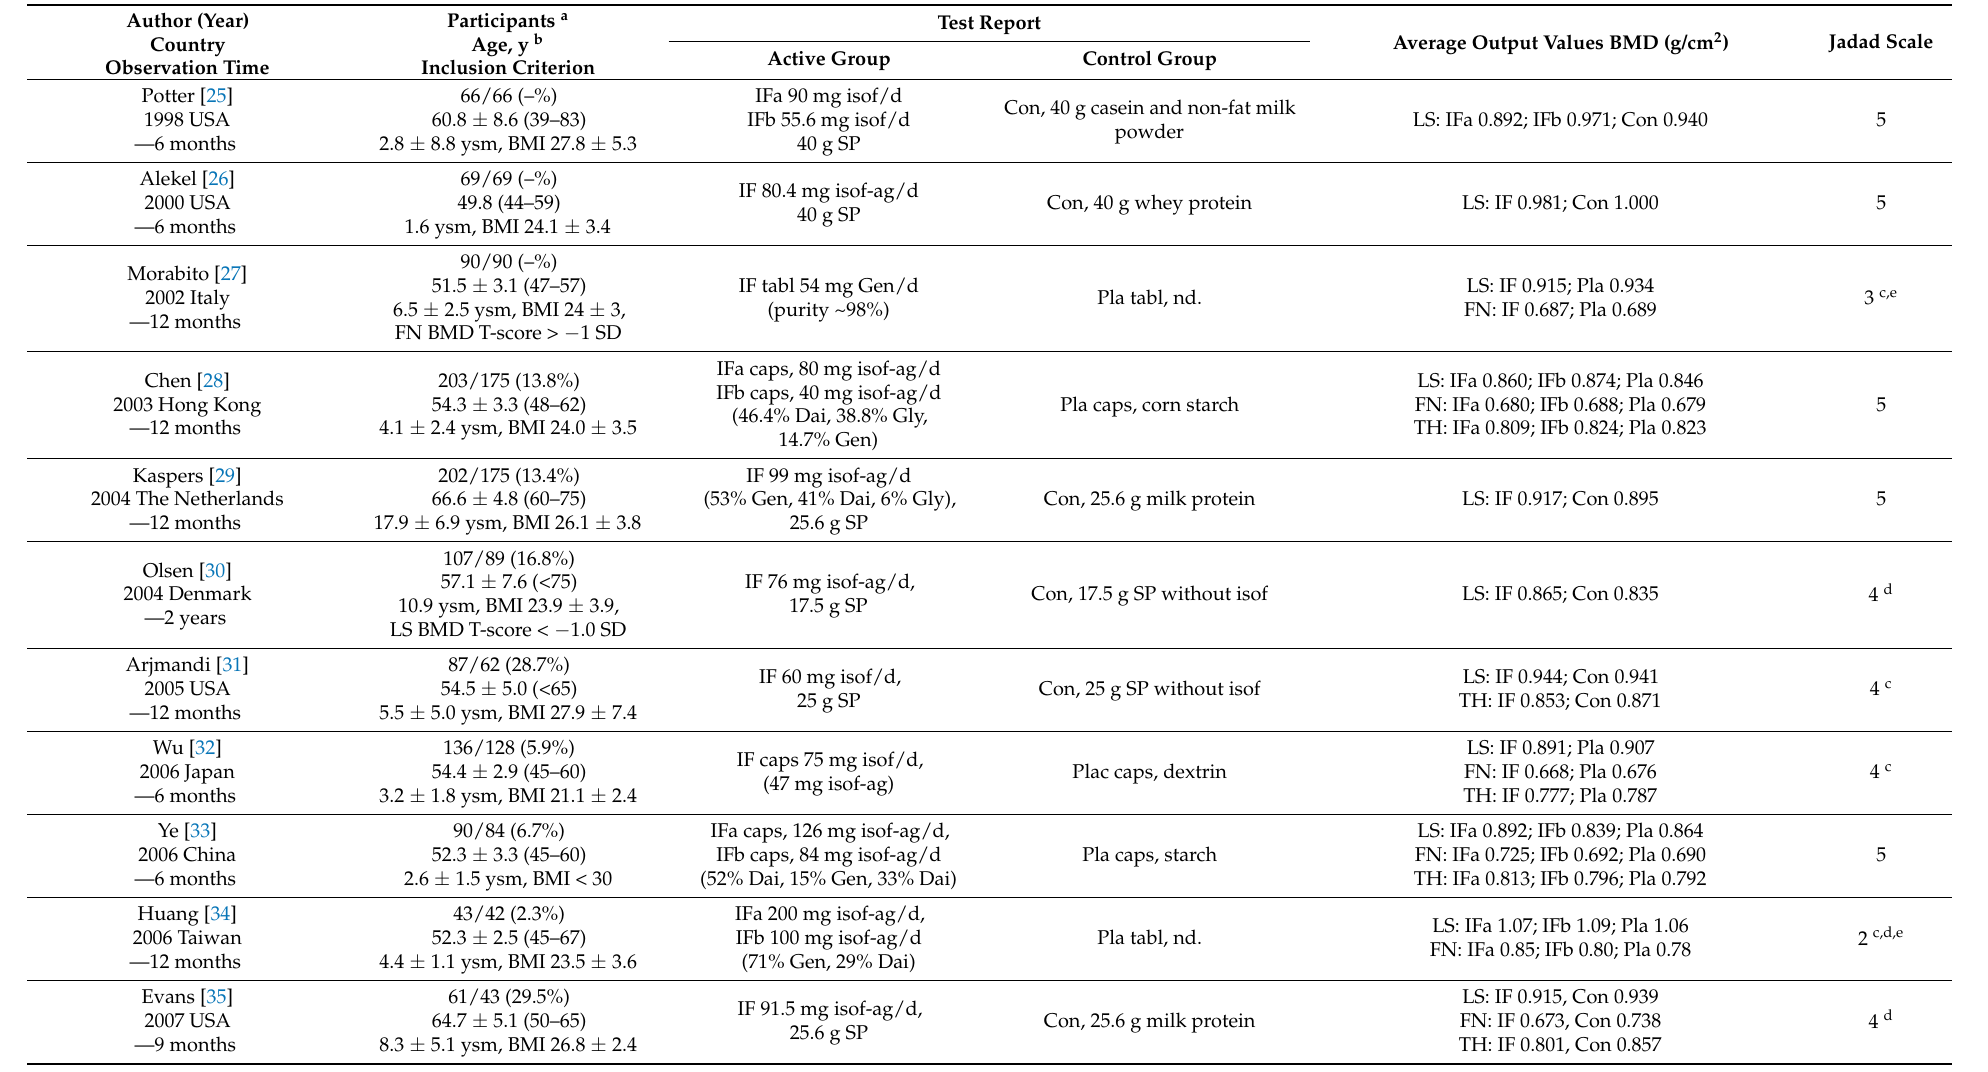
Table 1. Of the randomized blinded clinical trials with a control group on the influence of soy isoflavones on bone mineral density (listed